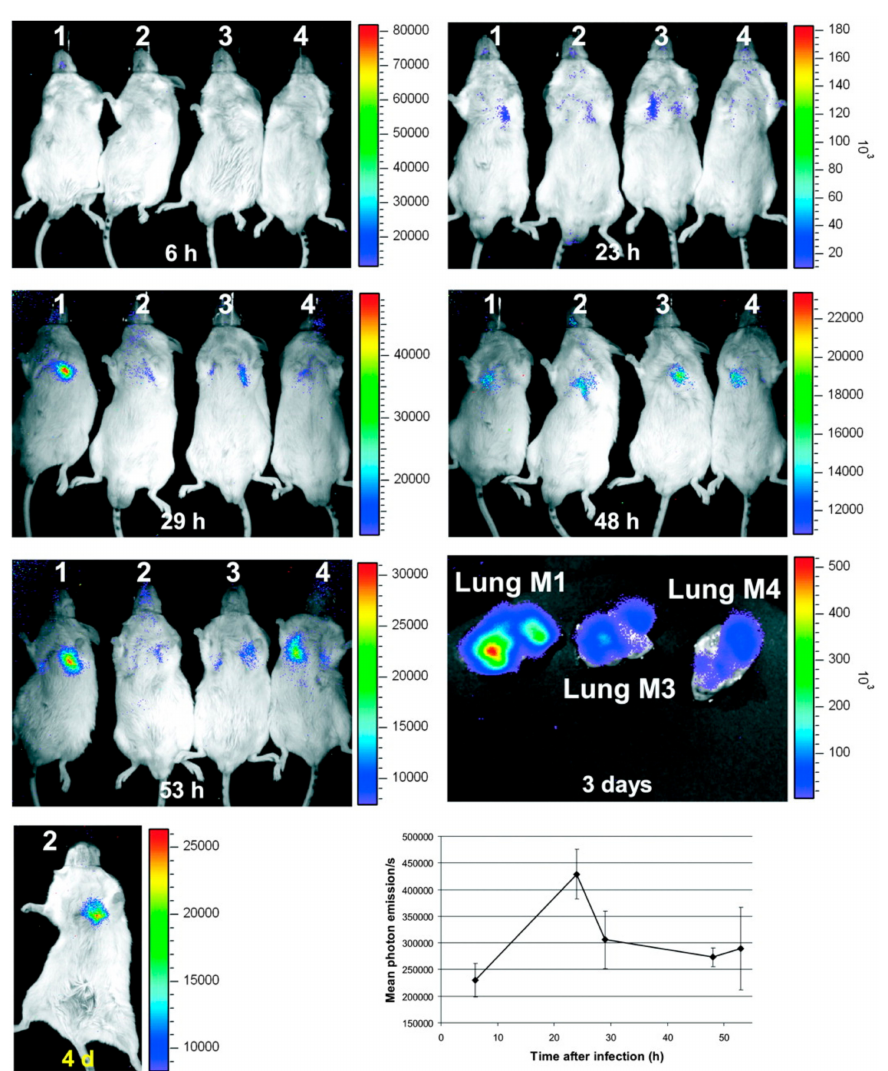
Figure 1. Bioluminescence imaging of aspergillosis. Evolution of luminescence emission from BALB / cJ mice after intra-nasal infection with 2 × 10 6 conidia of bioluminescent A. fumigatus . Emission of light peaked 23 h after injection before declining continuously until sacrifice. Ex vivo images were obtained directly after the last in vivo time point. The lower right graph shows the mean signal from the chest of mice through the experiment. Adapted with permission from Brock et al., Appl. Environ. Microb. 2008, 74 ,